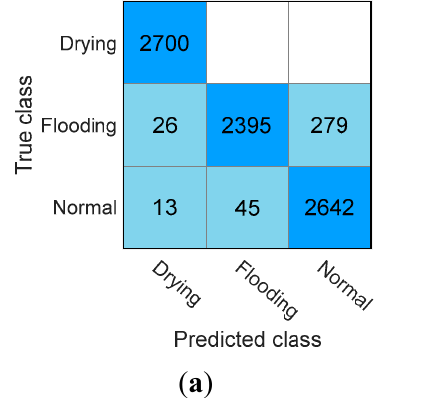
Figure 11. Confusion matrix for the SVM classifier training process ( a ) Sample classification ( b ) Prediction rate.